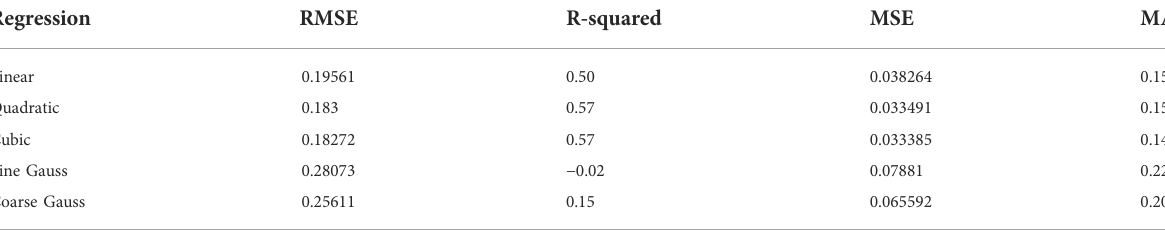
TABLE 5 Comparison of the effectiveness of training results under fi ve regression models. Regression